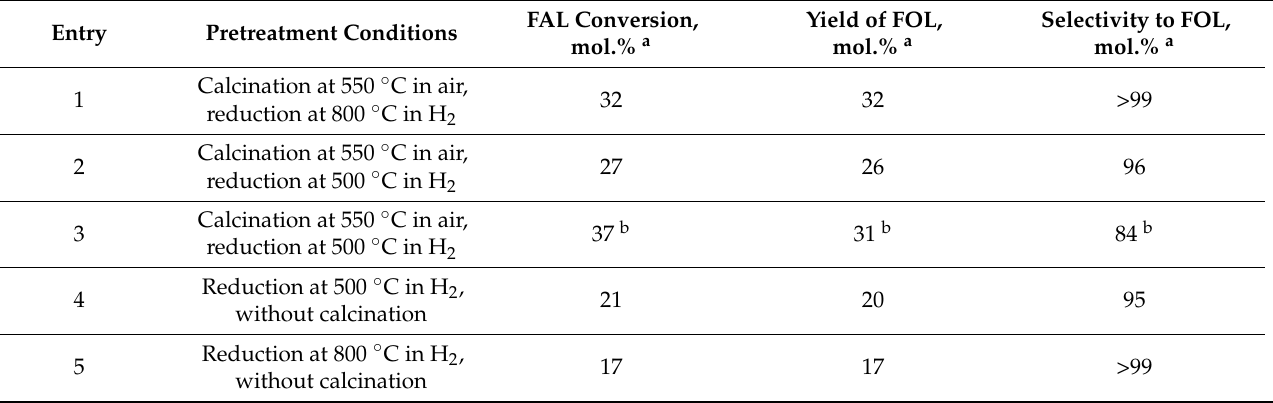
Table 4. Effect of pretreatment of CuCoAl-catalysts with atomic ratios (Co + Cu)/Al = 2 and Co/Cu = 1 on their performance in FAL hydrogenation at 90 ◦ C, 20 bar for 1